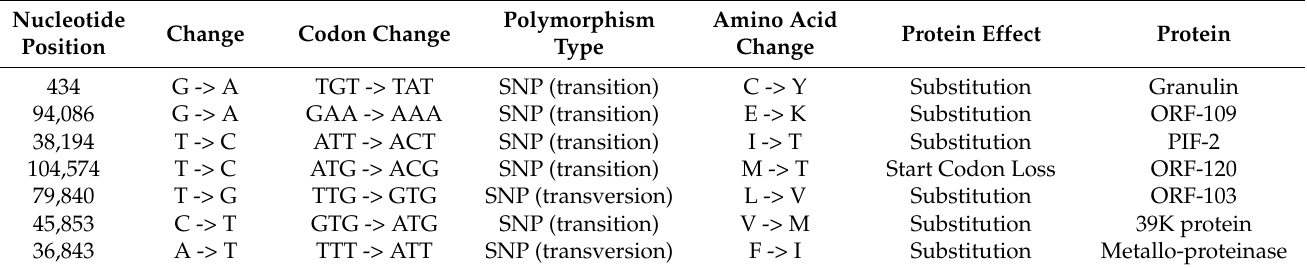
Table 3. SNPs identified in both the CrleGV-SA C1 and CrleGV-SA C5 genomes.